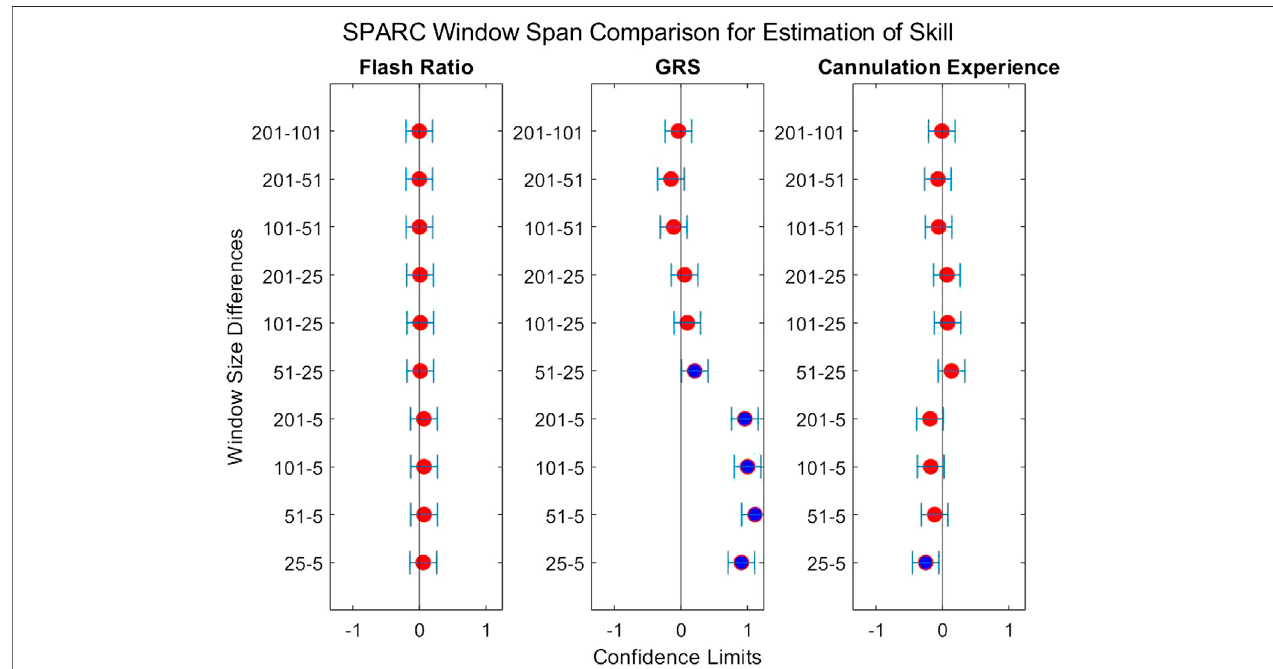
FIGURE 10 | Con fi dence intervals of each skill indicator metric ’ s association with SPARC between the tested window spans. If the con fi dence limits are both positive, the minuend is more associated with the corresponding skill indicator metric, and vice versa if the con fi dence limits are both negative. If the con fi dence interval passes through zero, there is no signi fi cant difference in the